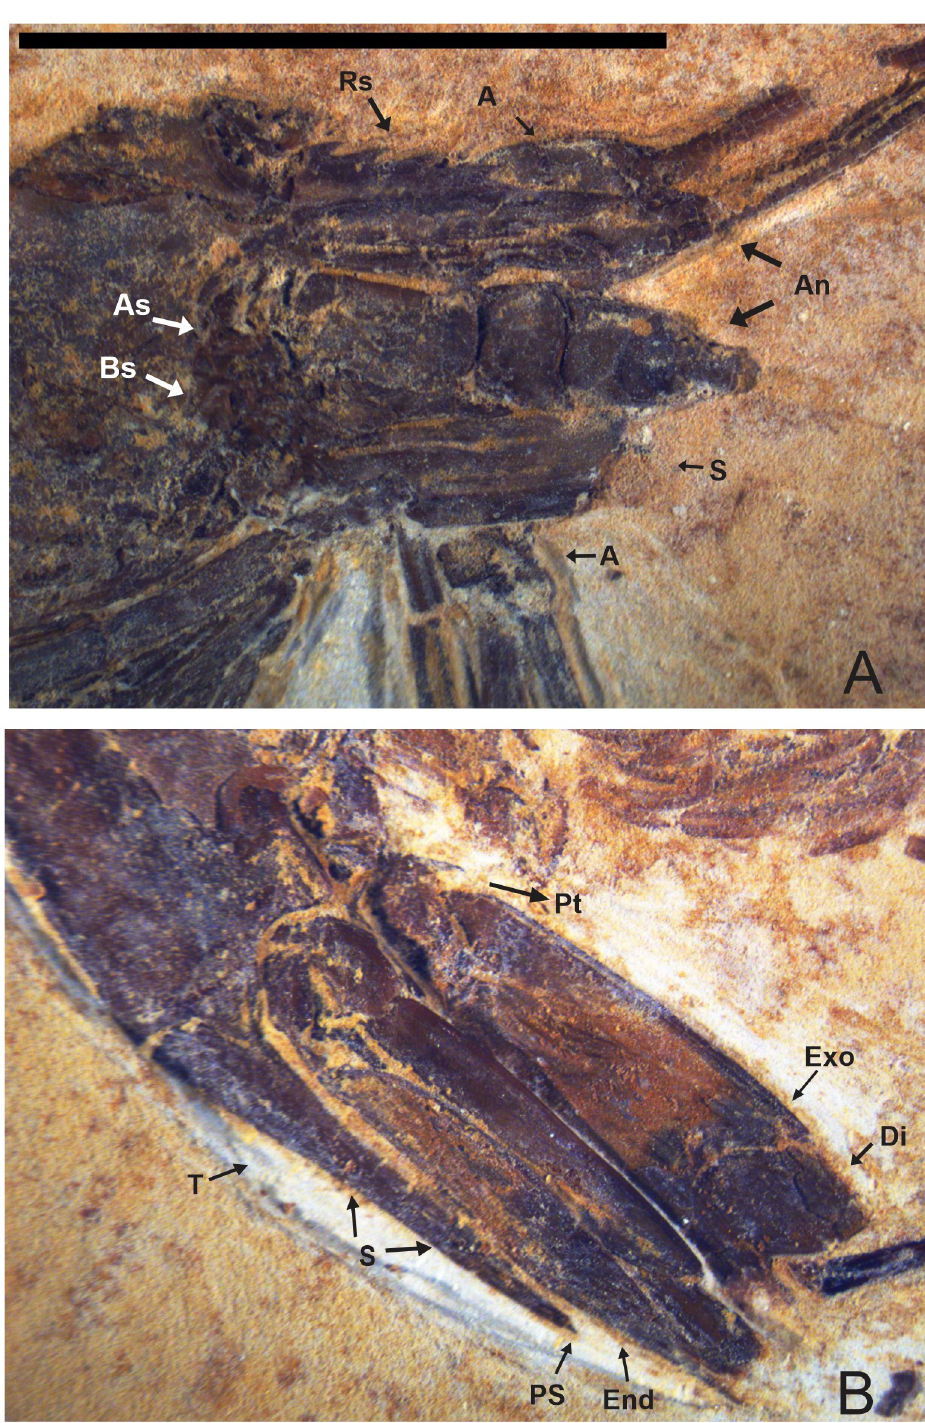
Fig 3. 2466/CRT (UFC). (A) Antennal and branchiostegal spines are visible. (B) Detail of the uropods and telson with posterior spines, exopod is slightly longer than the telson. Rs: Rostrum; A: Antenna; An: Antennule; S: Scaphocerite; T: Telson; S: Spines; Ps: Posterior spines; End: Endopodite; Exo: Exopodite; Di: Diaresi; Pt: Protopodite. Scale bar: 10 mm. Photo: Olga A. Barros.